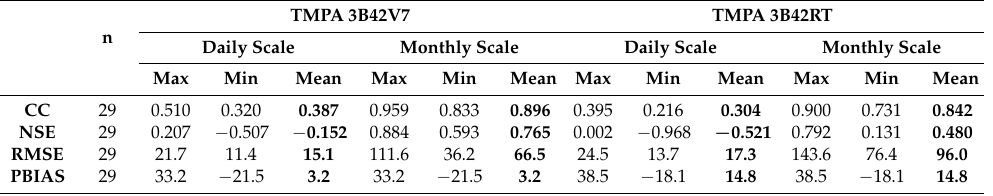
Table 3. Descriptive statistics for observation rain gauge and TMPA data in daily and monthly scale. TMPA 3B42V7 TMPA 3B42RT n Daily Scale Monthly Scale Daily Scale Monthly